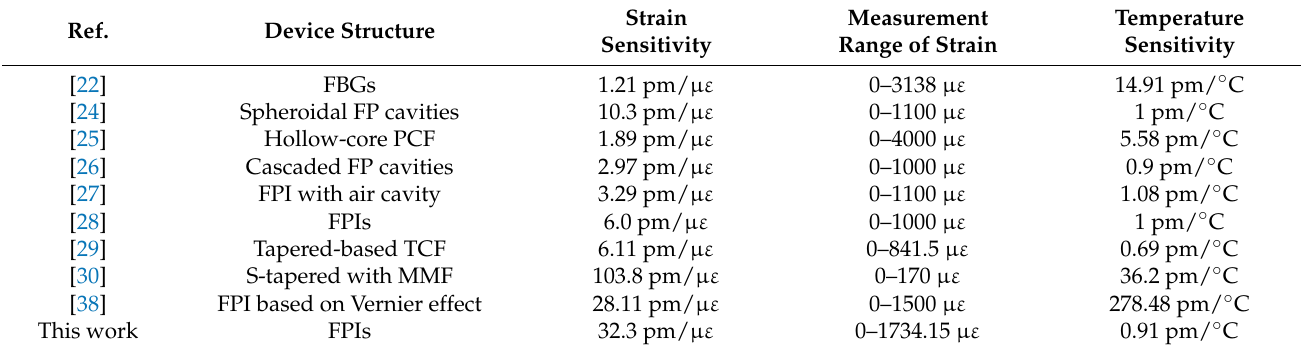
Table 1. Comparisons of the proposed sensors with other representative